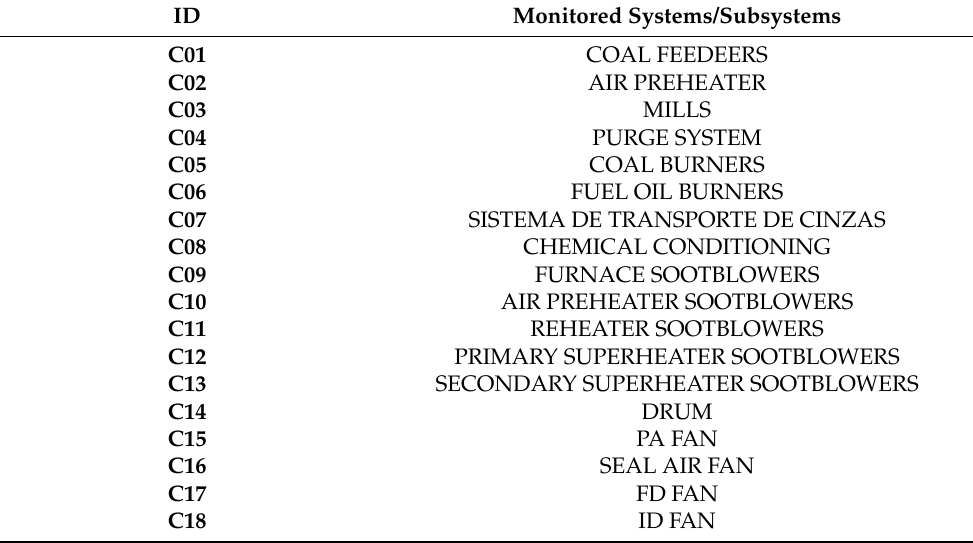
Table 4. Systems and subsystems monitored in the